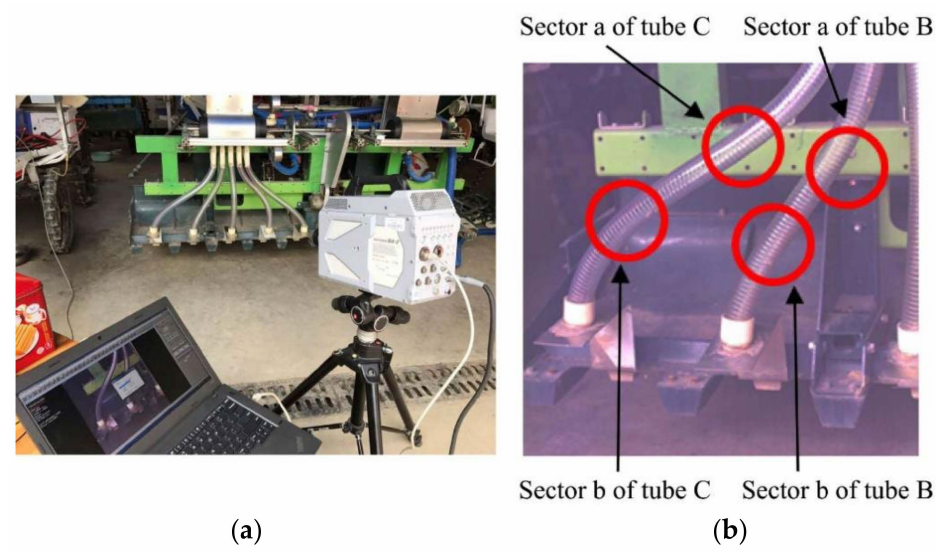
Figure 16. The high-speed photography of rice seed movement state with different tube angles. ( a ) Seed delivery experiment; ( b ) The division of collision zone.